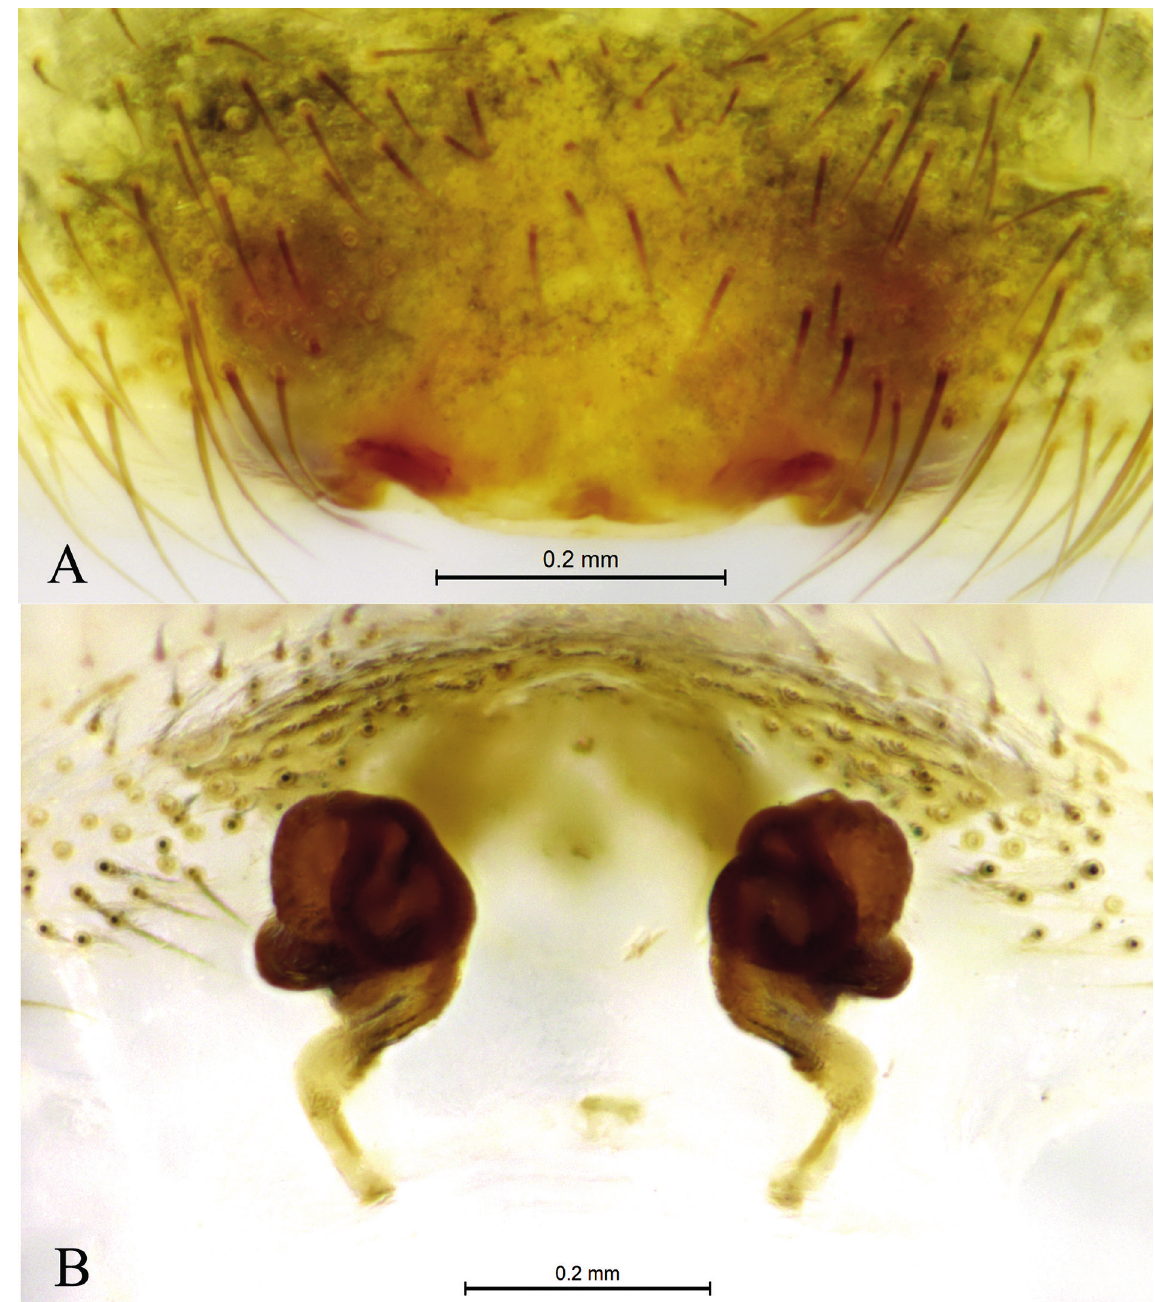
Fig. 21. Meta weining sp. nov., ♀, paratype (SWUC-T-TEg-08-03). A . Epigyne, ventral view. B . Vulva, dorsal